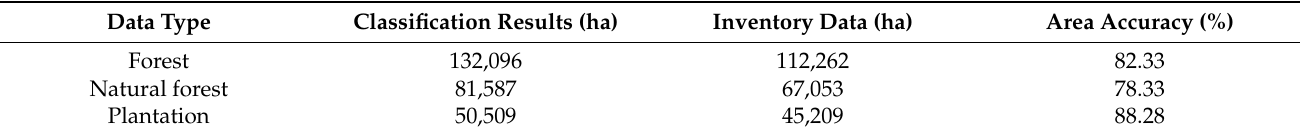
Table 3. Area of forest in Yanqing and area accuracy.